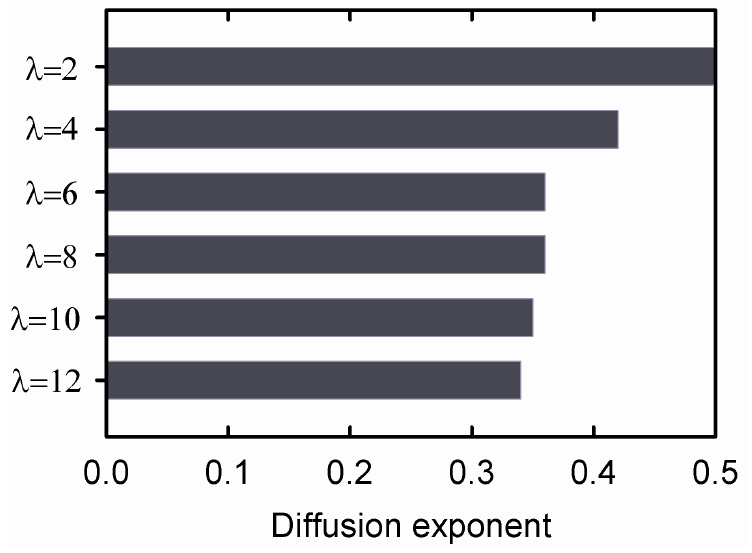
Figure 9. Exponents derived from diffusion measurements. A value of n = 0.5 indicates Fickian